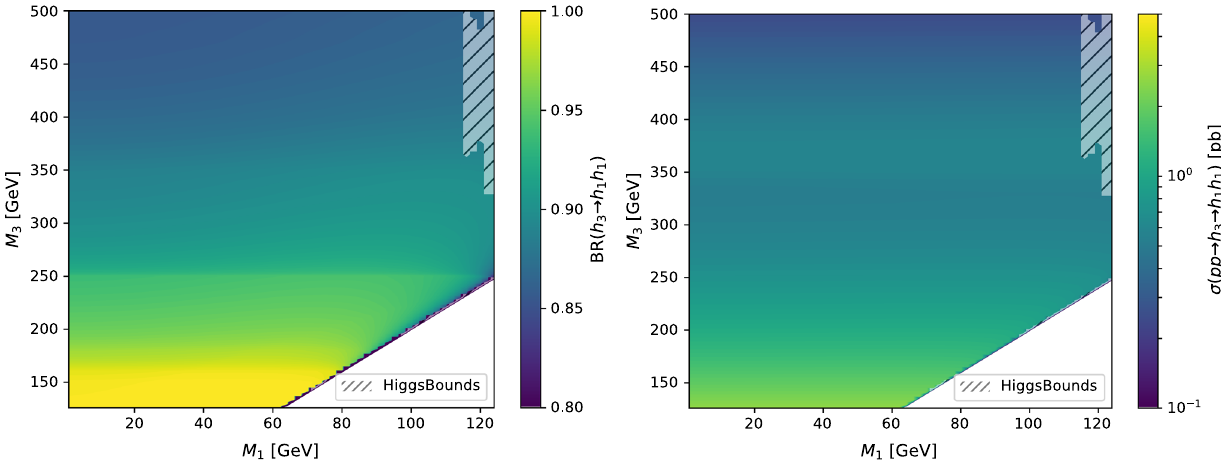
Fig. 13 Benchmark plane BP5 for the decay signature h 3 → h 1 h 1 with h 125 ≡ h 2 , defined in the ( M 1 , M 3 ) plane. The color code shows BR ( h 3 → h 1 h 1 ) (left panel) and the signal rate for pp → h 3 → h 1 h 1